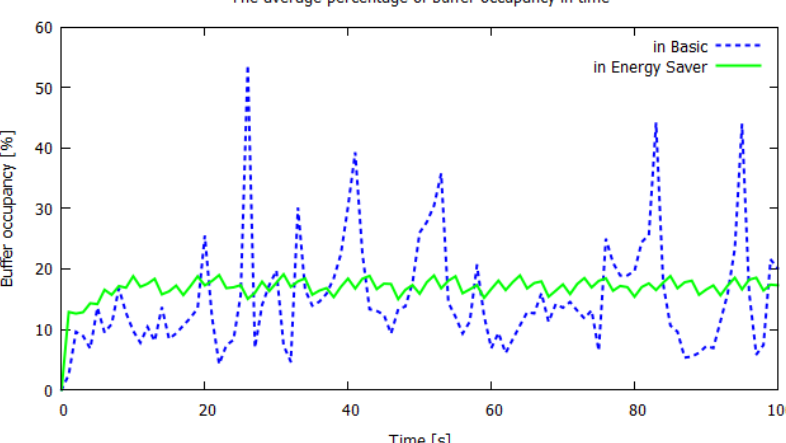
Figure 9. Average occupancy of router queues (percentage of buffer volume) as a function of time for basic and energy-saving